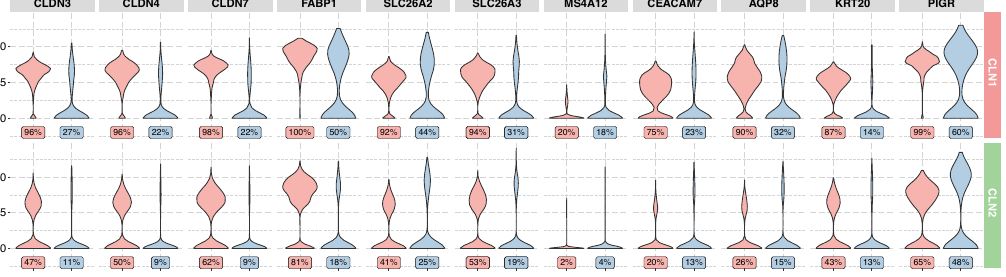
tissue sections. The y -axis shows log10-transformed counts. d Distribution of UMI counts per spot in the three annotated regions (mucosa, submucosa, and muscu- laris) visualized as violin plots. The y -axis shows log10-transformed counts. e Expressionof11epithelialmarkersinthemucosaforthetwoadultcolonsamples visualized as violin plots. A comparison between the two protocols is shown for each gene and the corresponding detection rate is highlighted below each violin plot.Thedetectionrateisde fi nedasthepercentageofspots(inthemucosa)where the gene is